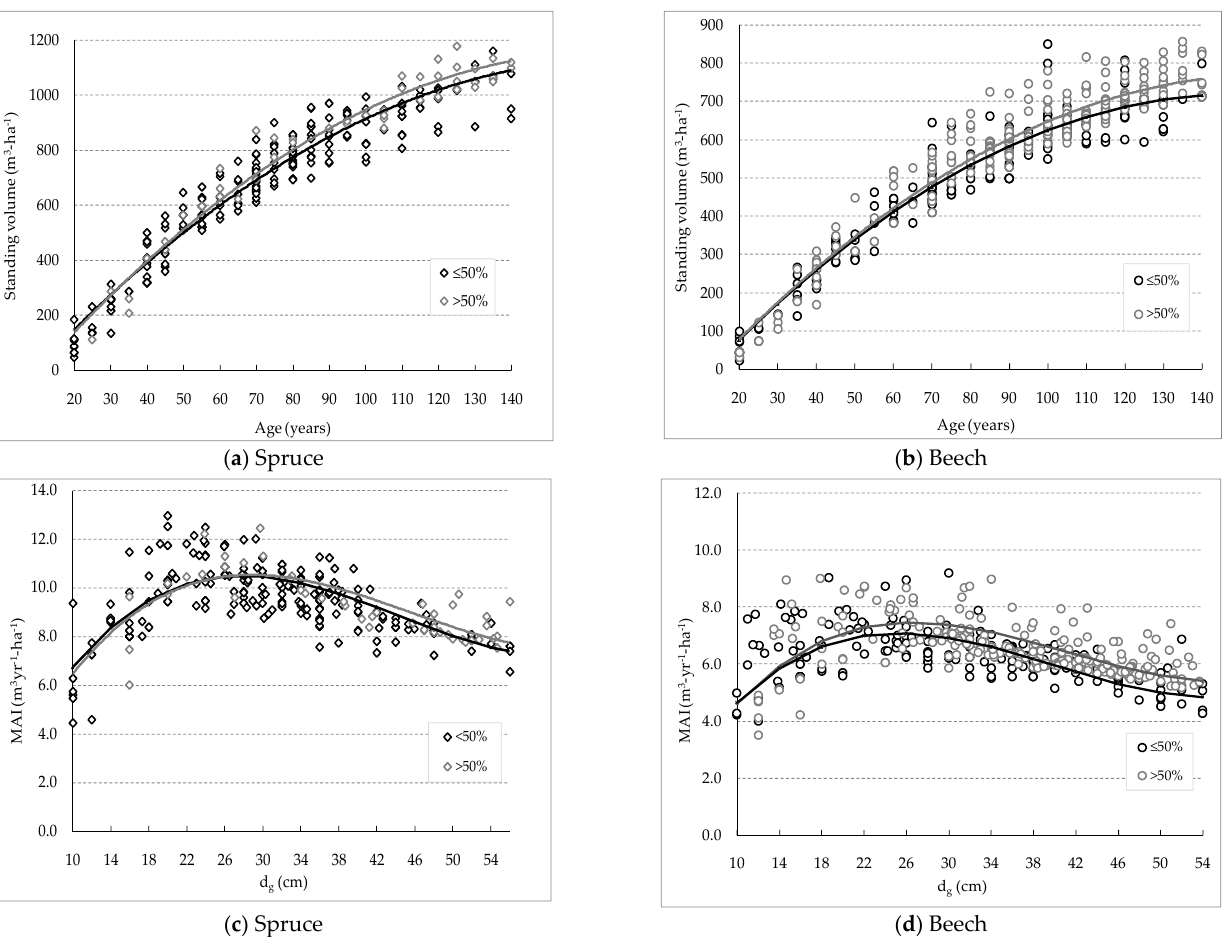
Figure 4. V in relation to age of: ( a ) spruce; and ( b ) beech; and MAI in relation to d g of: ( c ) spruce; and ( d ) beech. Values expressed per hectare of forest, assuming 100% pure stands. The MAI was derived from the V. The basal areas of trees belonging to generations of trees within the species were included in the quadratic d g calculation. Characteristic values for V and MAI for species in mixed stands were expanded a density of 1.0.